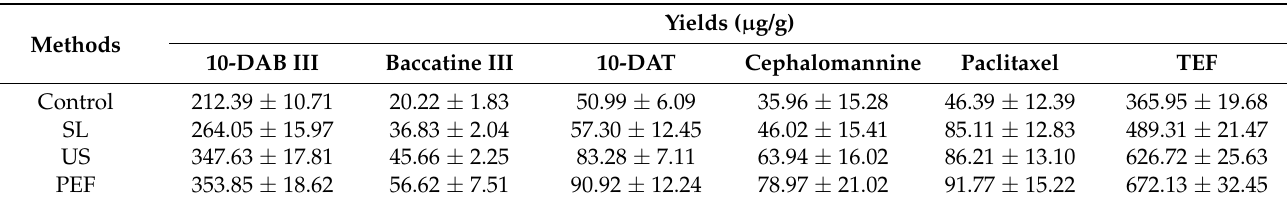
Table 4. The content of five compounds extracted with different